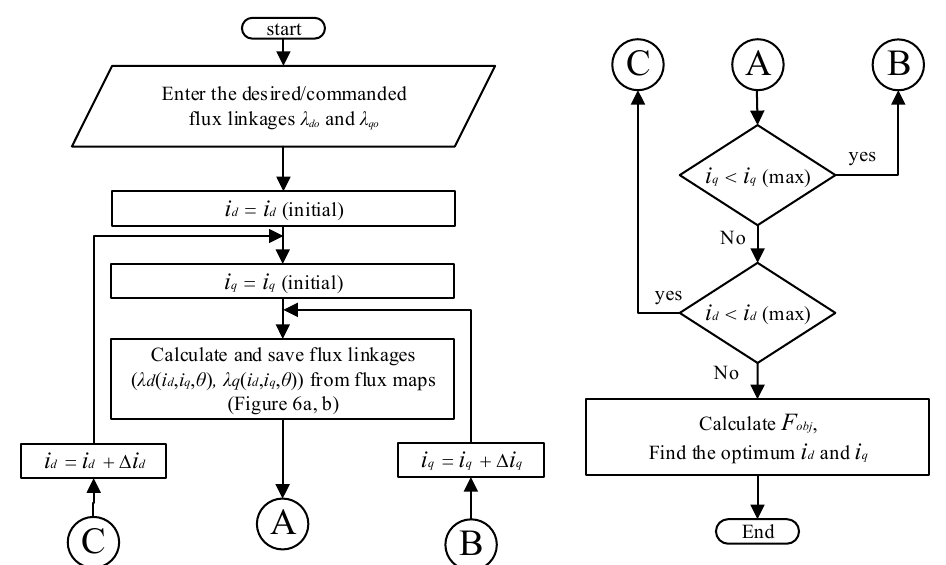
Figure 7. Flowchart for the inverse solution of currents versus flux linkages.